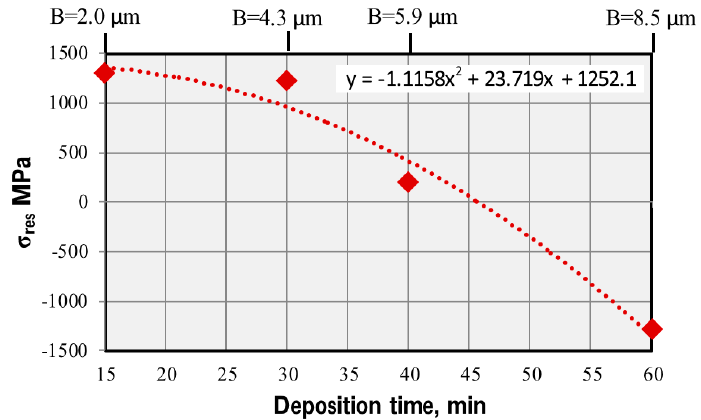
Table 4. Used Young’s modulus (E) values for various crystallographic directions of ZrN.